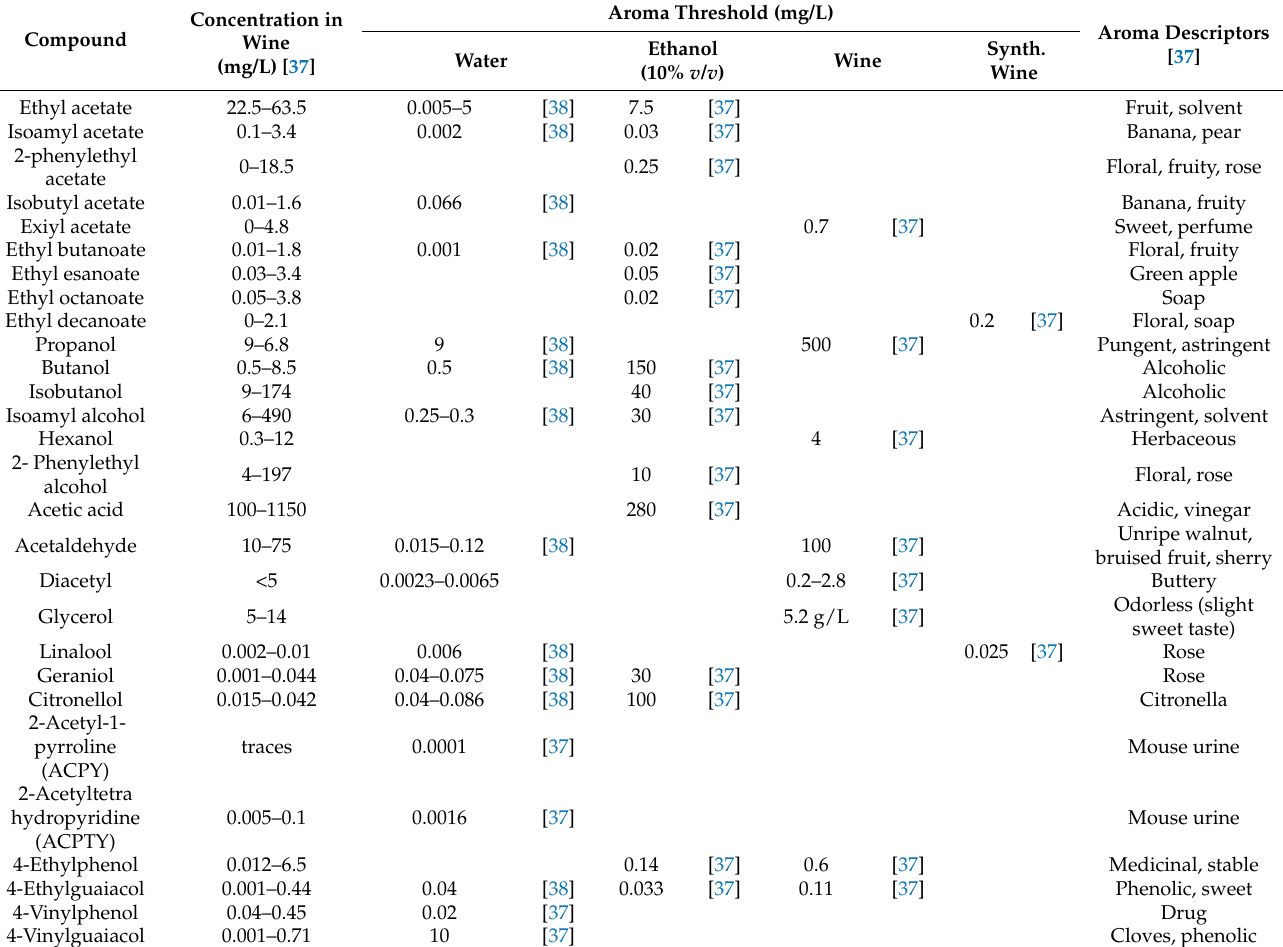
Table 1. Concentrations and odors corresponding to the different aroma compounds in